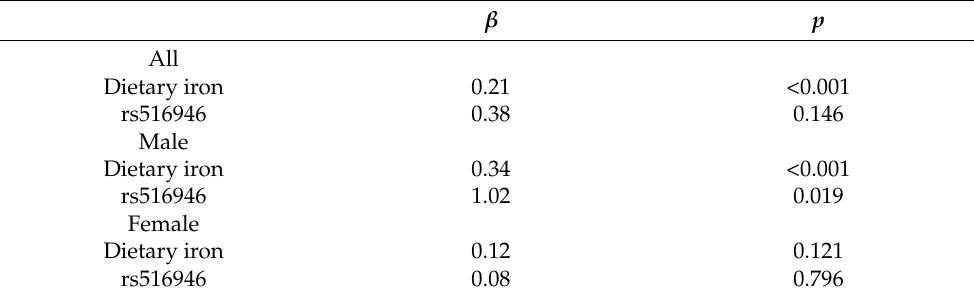
Table 2. Logistic regression results for MetS risk according to dietary iron and SNP rs516946 in the participants stratified by sex 1